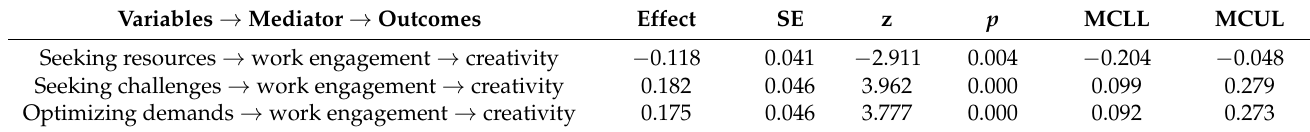
Table 2. Results of the indirect effects of job crafting approaches on creativity through work engagement (within-level). Variables → Mediator → Outcomes Effect SE z p MCLL MCUL − 0.118